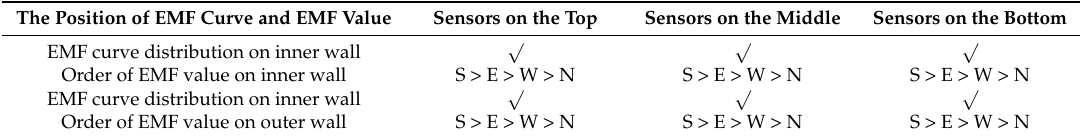
× : Dis-similar to the Figure 9 distribution. ×: Dis-similar to the Figure 9 distribution. √: Similar to the Figure 9 distribution.